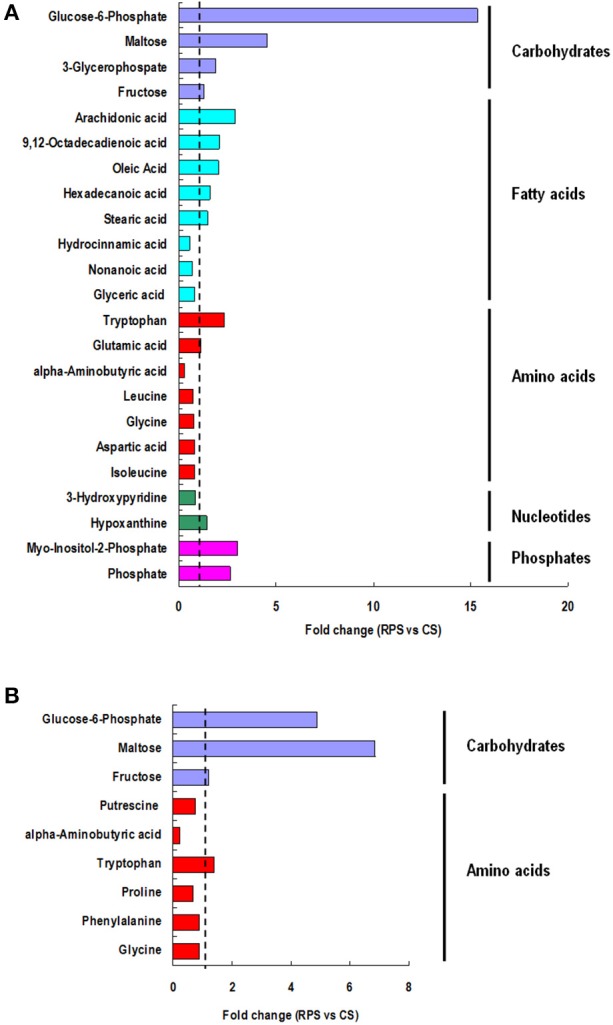
Significant compounds. Metabolites accountable for class discrimination with VIP > 1, fold change > 1.5, and P < 0.05 were listed. (A) cecum; (B) colon.